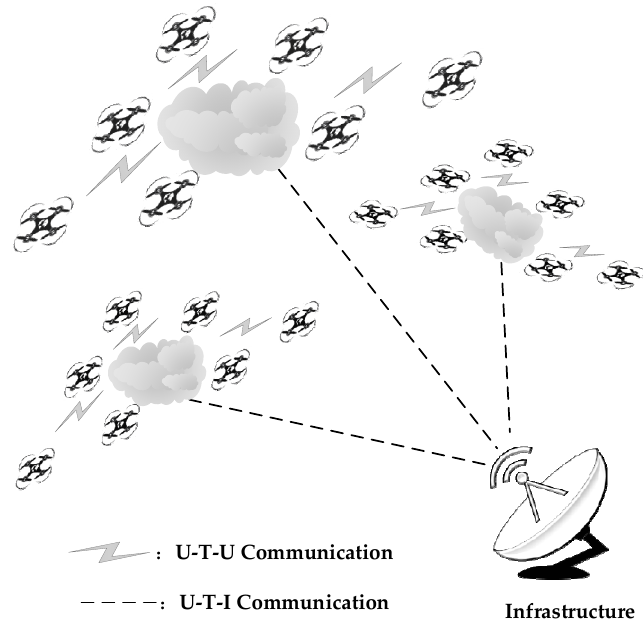
Figure 4. Schematic of a multi-group swarm Ad hoc network.